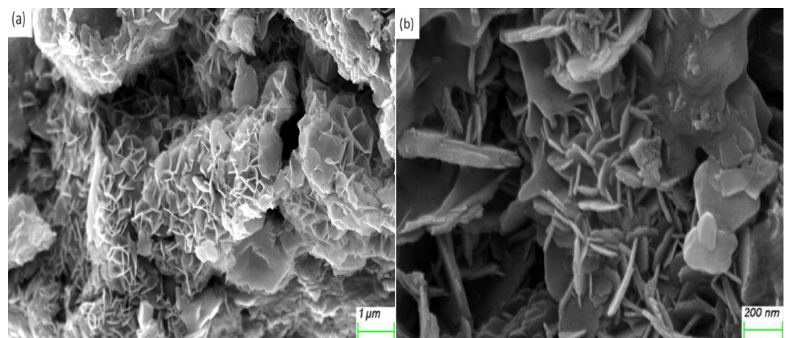
Figure 1. Scanning electron microscopy (SEM) images of the activated-charcoal (AC)—supported nanoscale zero-valent iron (NZVI) particles. ( a ) image at low magnification; ( b ) image at high magnification.